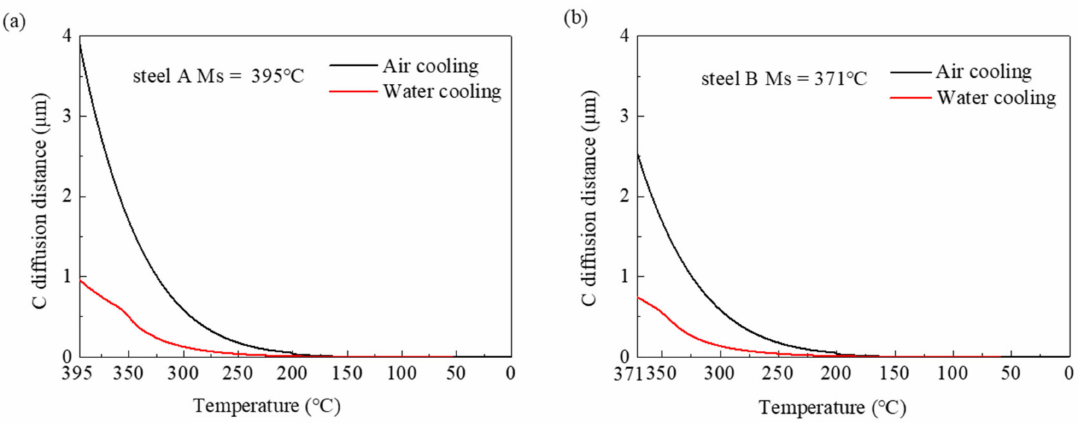
Figure 8. C diffusion distance during martensite transformation for steel A ( a ) and steel B ( b